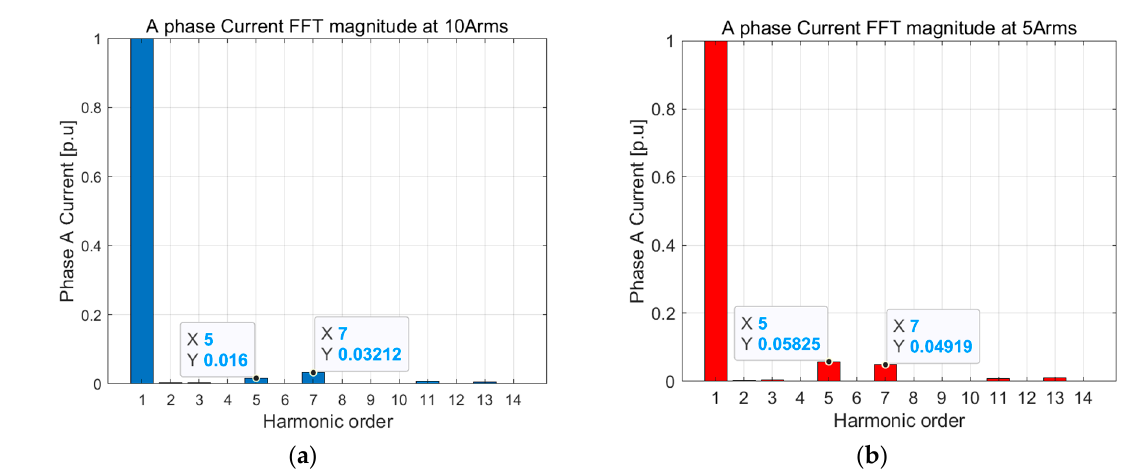
Figure 14. A-phase current FFT magnitude plot at ( a ) 10 Arms and ( b ) 5 Arms.